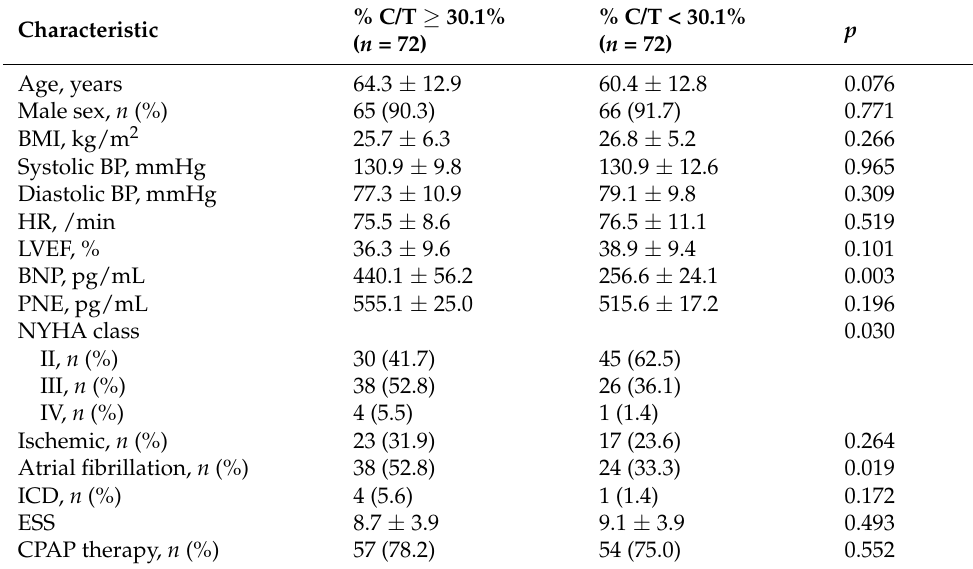
Table 1. Baseline characteristics of patients in the two groups.